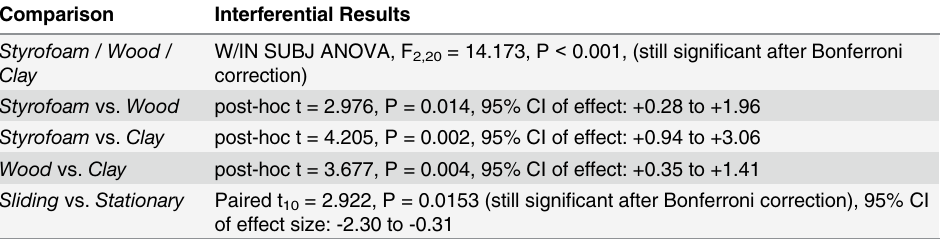
Table 6. Inferential